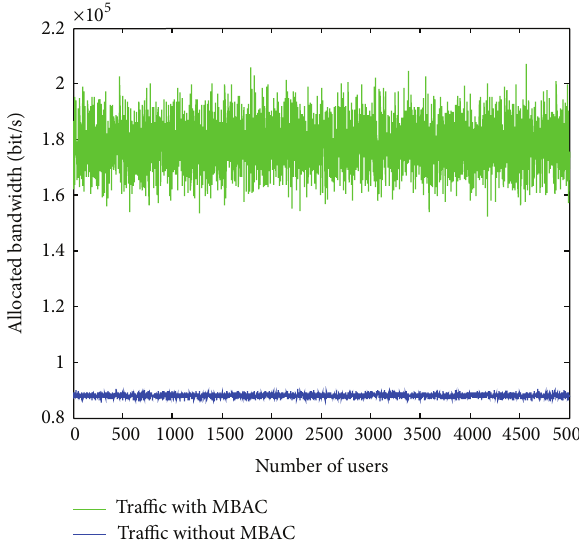
Figure 4: Increase of allocated bandwidth.